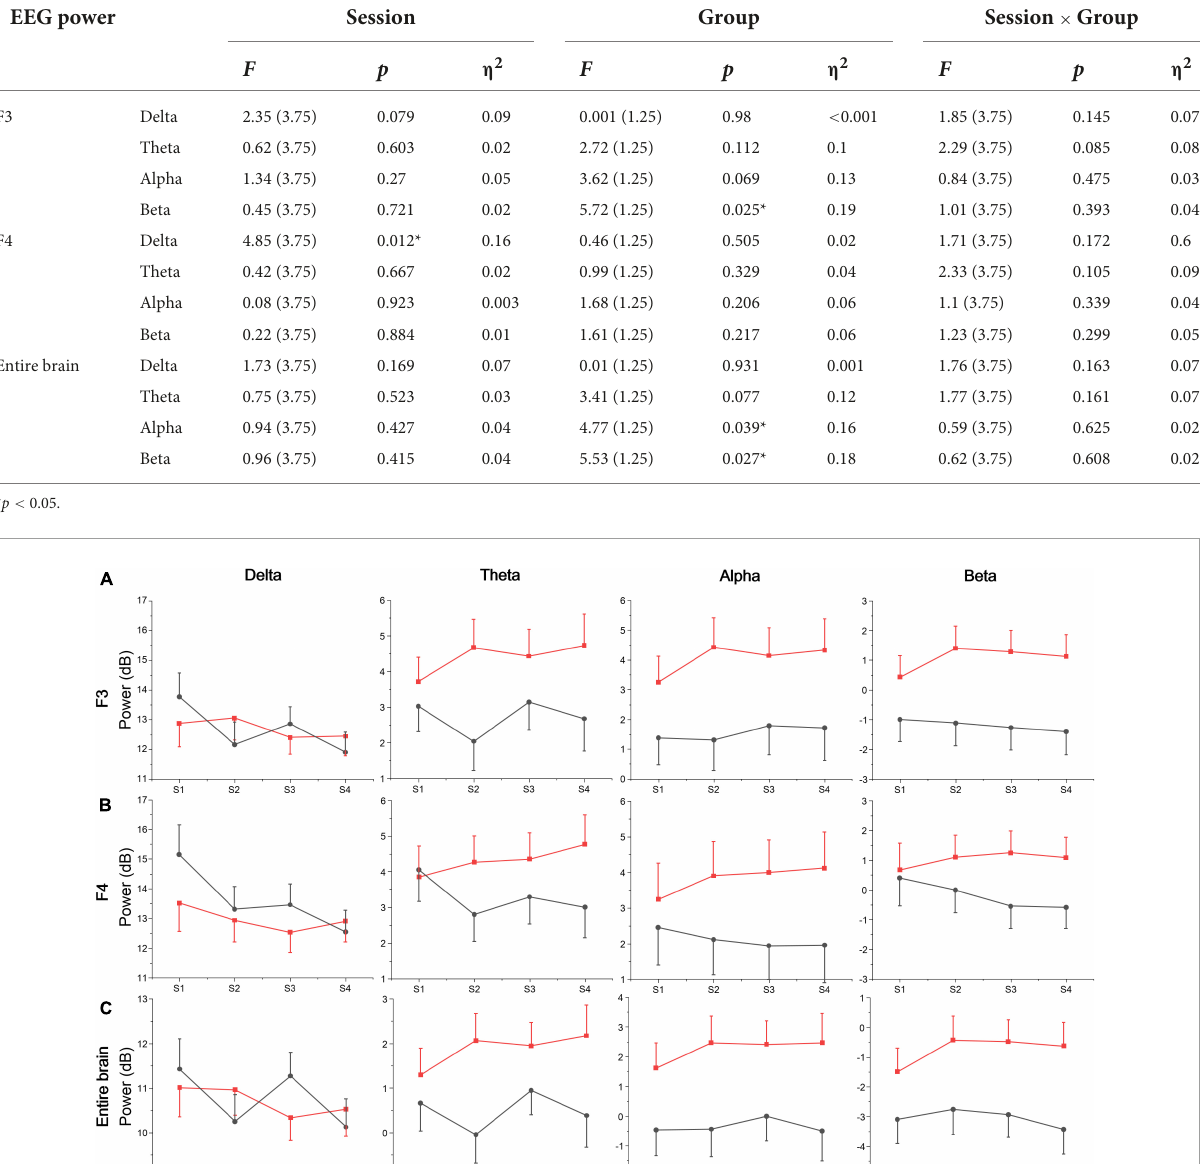
FIGURE4 EEG band power of (A) F3, (B) F4, and (C) the entire brain average at each session.